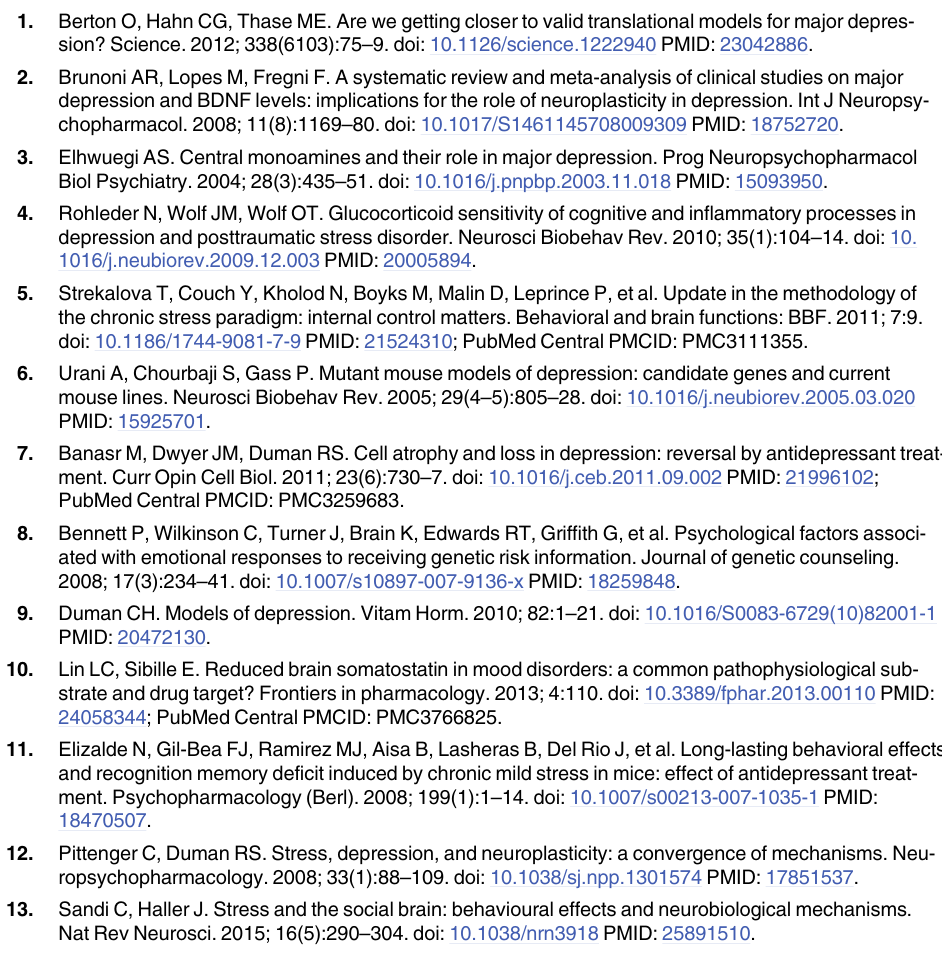
S2 Table. Filtering transcriptome raw data and alignment. S3 Table. Filtering small RNA library raw data and quality control. S4 Table. The network of microRNA and mRNA. S5 Table. miRNA changes in psychiatric disorders from other studies in comparison with our